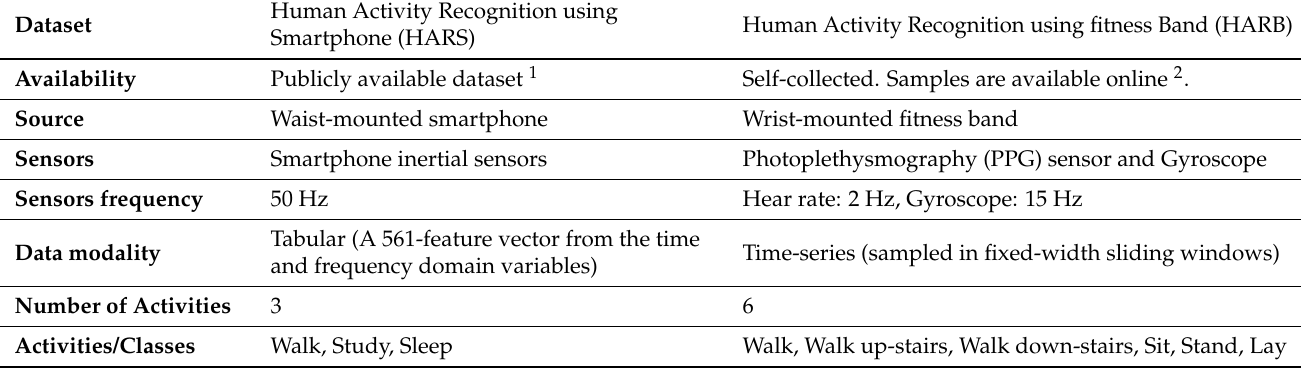
Table 2. HARB and HARS datasets